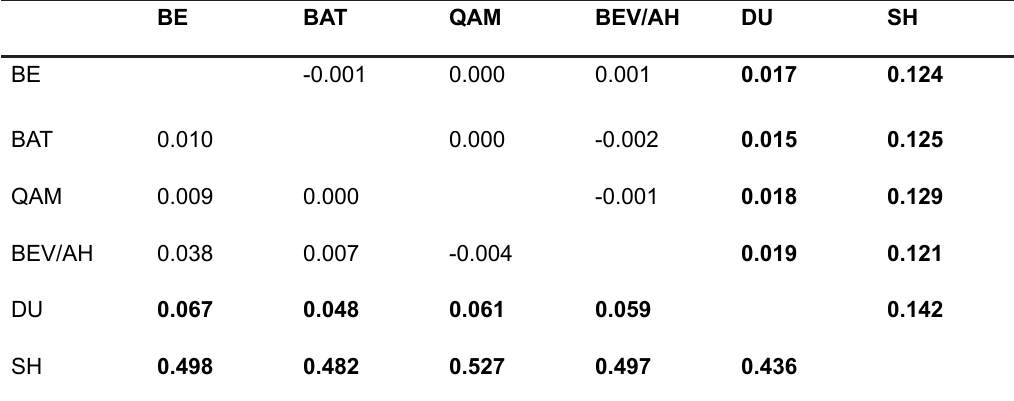
Table 2. Genetic differentiation between pairs of subpopulation locations. F ST1 above diagonal; Jost’s D EST2 below diag- onal. Values significantly different from zero are in boldface font ( ɑ = 0.05). For explanation of abreviations of studied caribou herds, please see Table 1.